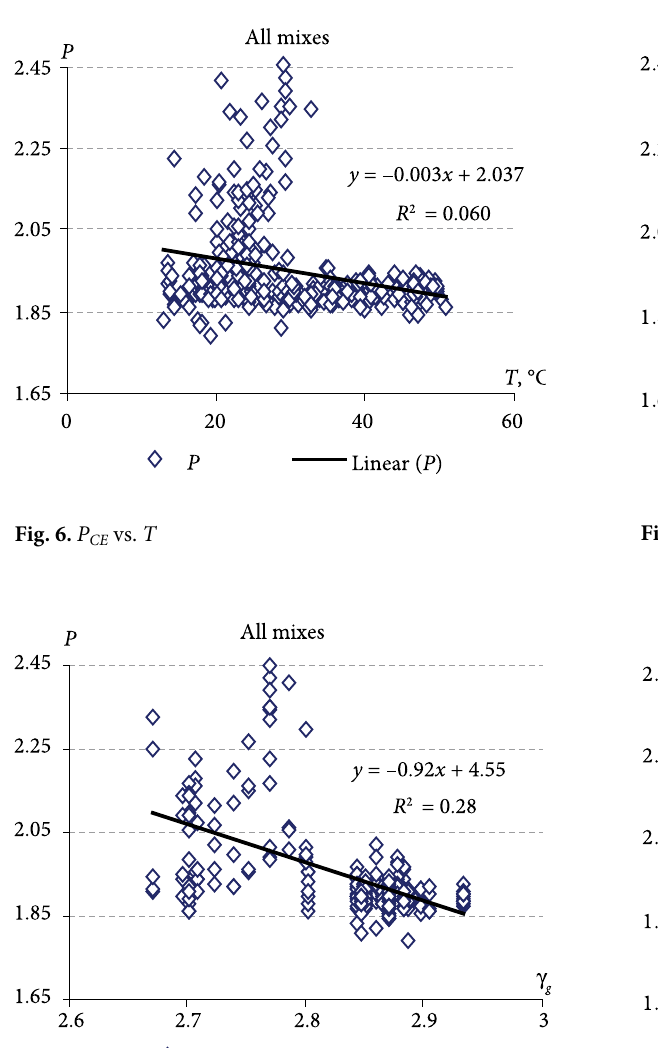
Fig. 4. P CE vs. G